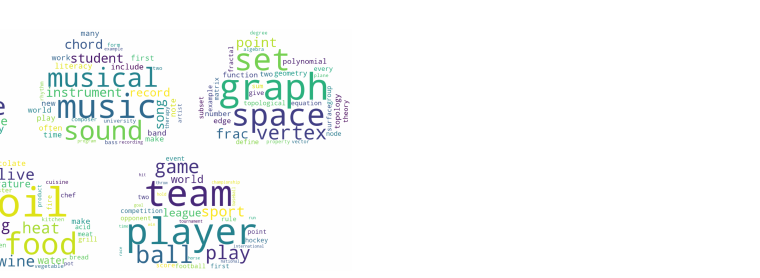
Figure 9. Word cloud representation of a subset of topics; dataset D1, TF-IDF weighting scheme, K = 10.